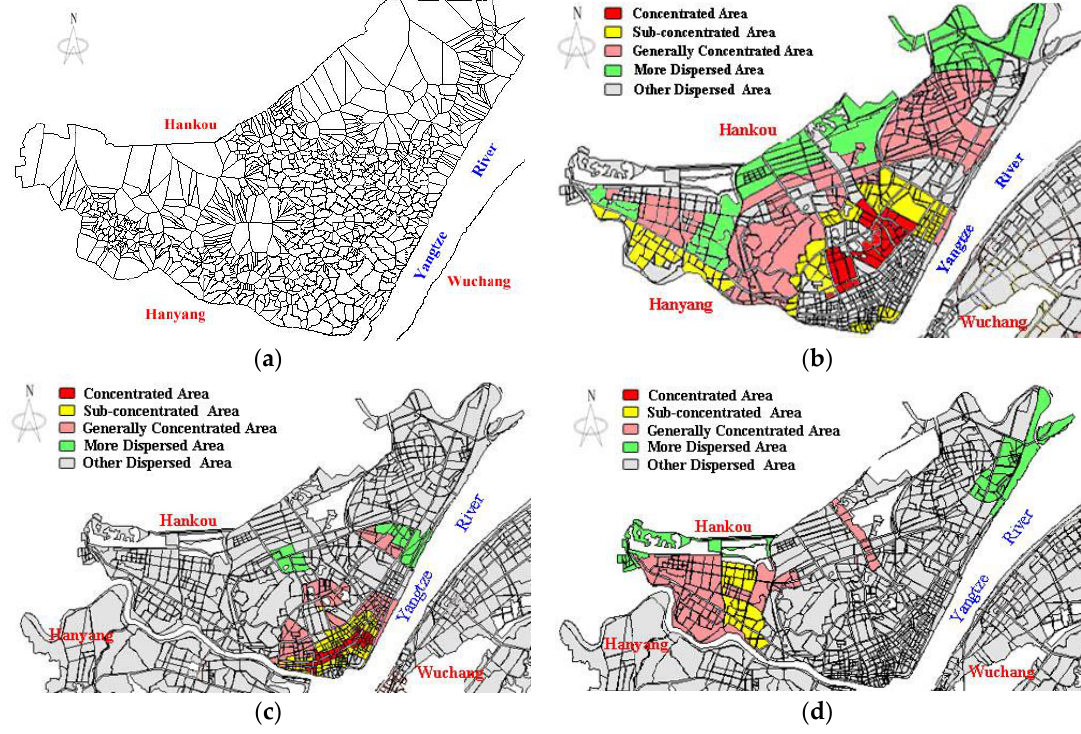
Figure 4. The spatial clustering classification results of the study area. ( a ) The Voronoi polygons of the study area; ( b ) spatial clustering classification results of residential land use; ( c ) spatial clustering classification results of commercial land use; and ( d ) spatial clustering classification results of industrial land use.